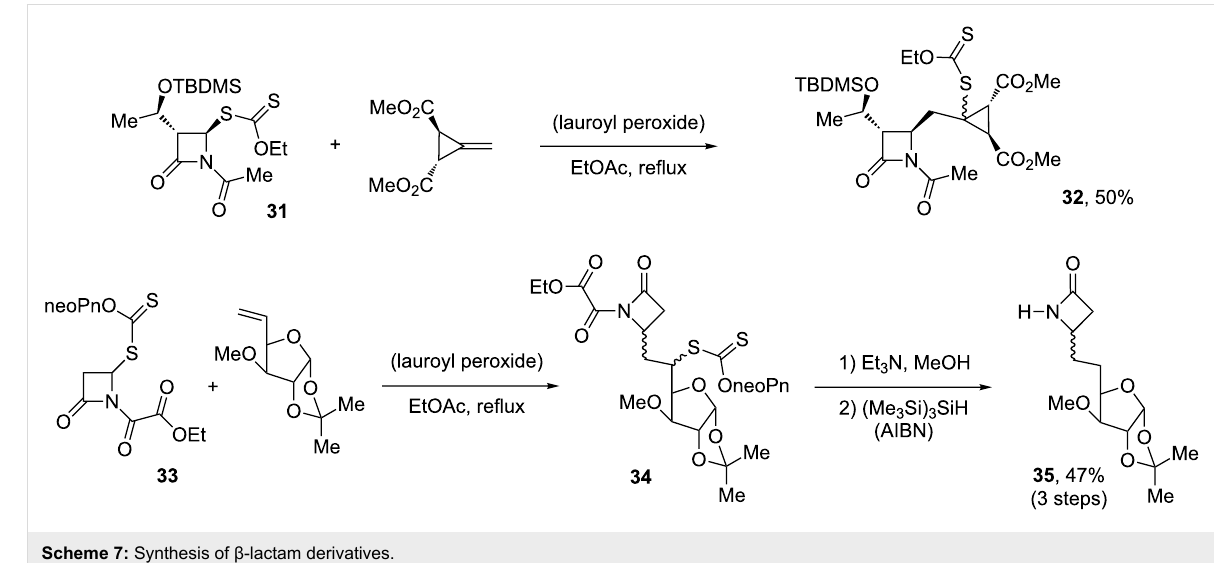
Scheme 7: Synthesis of β -lactam